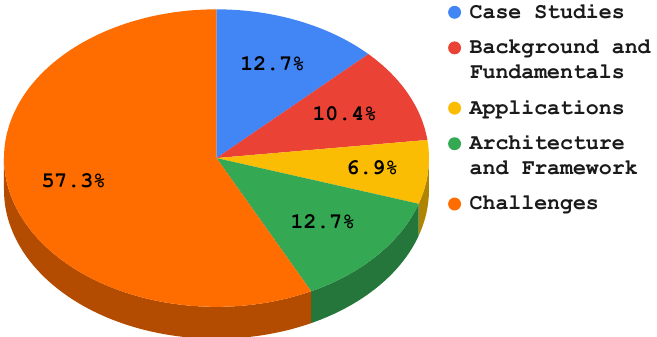
Figure 6. Percentage breakdown of the literature in federated learning in edge computing.